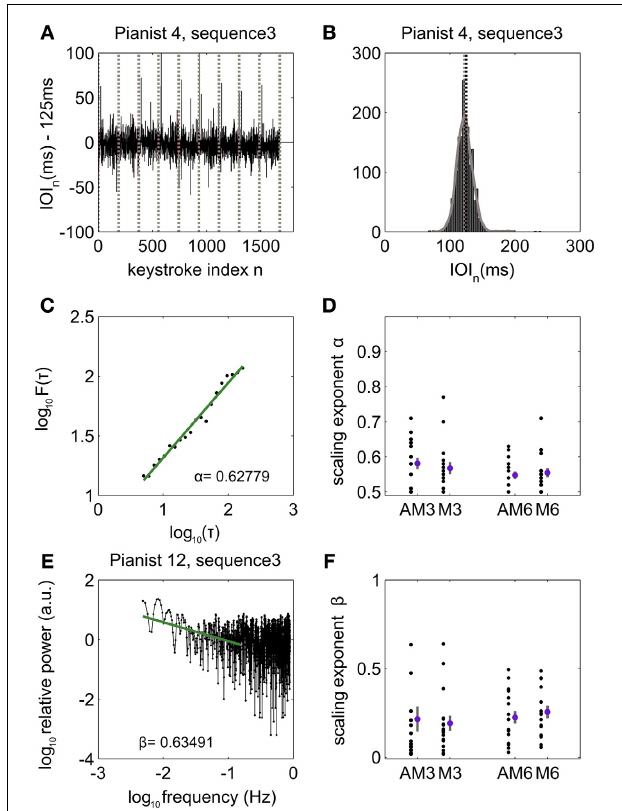
FIGURE 3 | Long-range temporal correlations during piano performance. (A) Representative time series of inter-onset-interval (IOI, ms) values in pianist #4, during performance of sequence type 3. Vertical lines denote boundaries between trials corresponding to renditions of the same sequence type. The IOI fluctuates around the nominal IOI of 125ms with a mean of − 2.19ms, indicating that on average the pianist played very closely to the rehearsed tempo. (B) The probability density function (pdf) of the time series of IOI in all patients and conditions was non-Gaussian and right skewed in 51% of all cases (tested for each patient, sequence type and auditory feedback condition separately: chi-square goodness-of-fit test rejected the null hypothesis of the distribution being a normal distribution, p < p th = 0.0001), whereas in 49% of all cases the null hypothesis of Gaussian distribution could not be rejected at the 0.05 level. Here the histogram and fitted pdf are displayed for the IOI values of pianist #4 performing sequence type 3. (C) log–log plot showing power-law scaling behavior for the fluctuation function F (τ) with increasing time scales τ spanning 5–200 keystrokes. F (τ) is computed from the variance of the detrended time signal. The scaling exponent α represents the slope of the linar fit. Representative patient #6 playing musical piece 3. (D) Distribution of the first-order DFA scaling exponents across all pianists (black dots) during audiomotor (AM) and motor (M) conditions and playing musical sequence 3 and 6. The values of the scaling exponents are displayed after subtraction of the bias introduced by DFA in the estimation of the degree of LRTC. The mean and standard error of the distribution of bias-corrected scaling exponents for each condition AM3, M3, AM6, M6 are plotted right to the distribution of the values from all pianists. (E) Spectral power density plotted against the log base 10 of the frequency > 10/ N , with N being the data length ( ∼ 2000 keystrokes). Representative case for pianist 12 playing sequence 3. The segment between 10/ N < f < 0 . 02/ T 0 , with T 0 = 0 . 200s (instructed IOI), corresponded to power-law 1/ f β scaling behavior and is represented here by the green line (following Gilden et al., 1995). The best fit line to the PSD in this range had exponent β = 0 . 63491. (Continued)